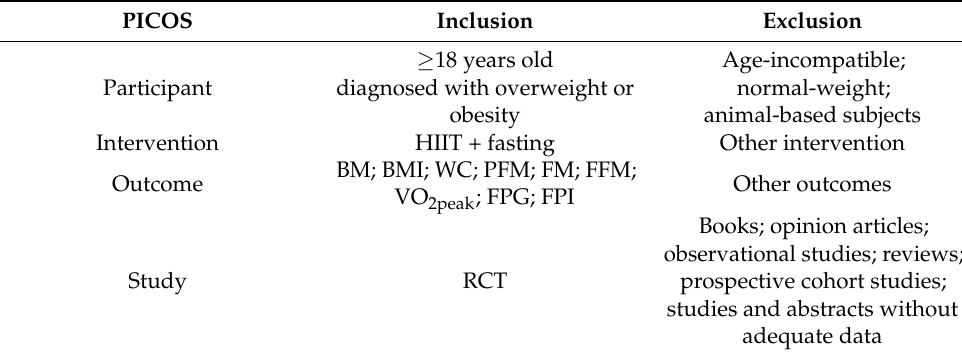
Table 1. Criteria for inclusion and